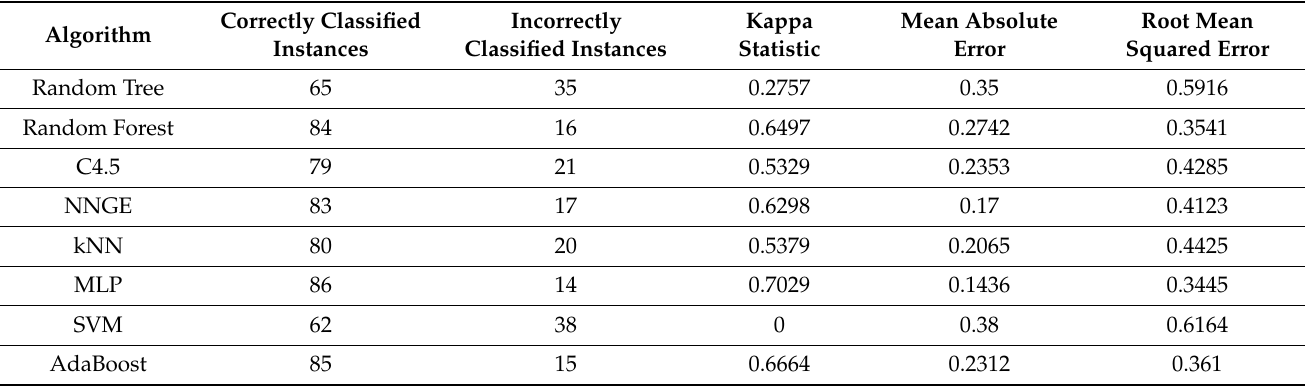
Table 11. Results obtained with different classification algorithms for assessing the need for alteration of glaucoma